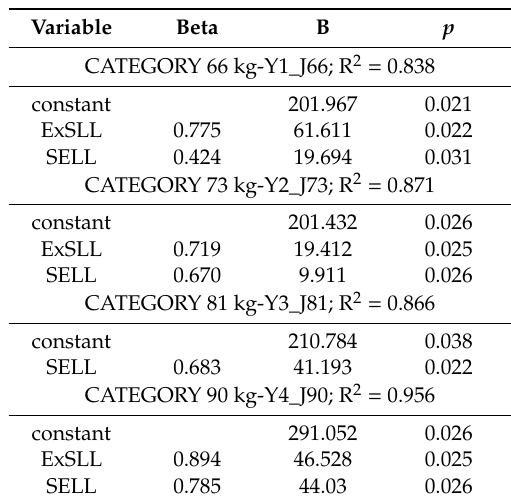
Table 3. Biometric models of significant ranking predictors among the variables of explosive strength and strength endurance of the lower and upper limbs in particular weight categories (66, 73, 81 and 90